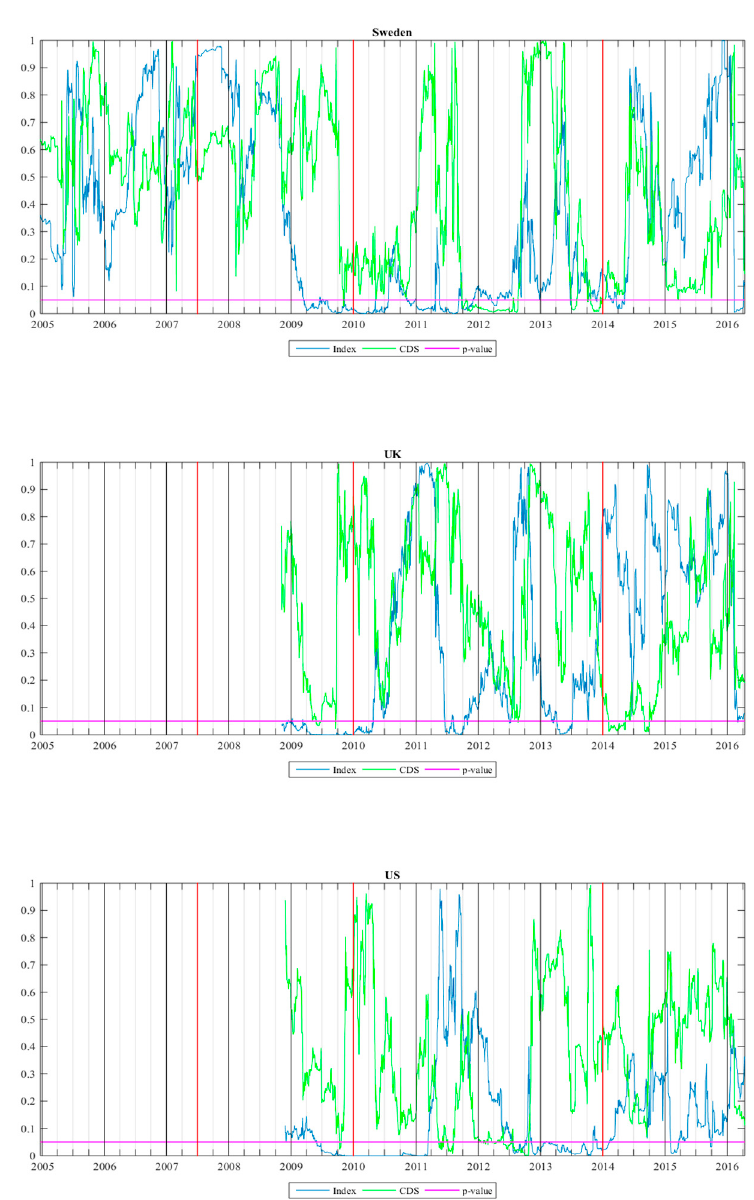
Figure 3. Rolling vector autoregressive (VAR) model estimation results for sovereign returns. This figure shows the p -values of the rolling test statistic testing the null hypothesis that stock returns do not Granger-cause sovereign CDS returns (blue line) and the null hypothesis that sovereign CDS returns do not Granger-cause stock returns (green line) for each European country and the US. The sample period is 6 January 2004–12 April 2016 and the significance level indicated on the graphs is equal to 0.05 (pink line). The vertical red lines mark the beginning of the different sub-periods: global financial crisis, Eurozone sovereign debt crisis and post-crisis period.